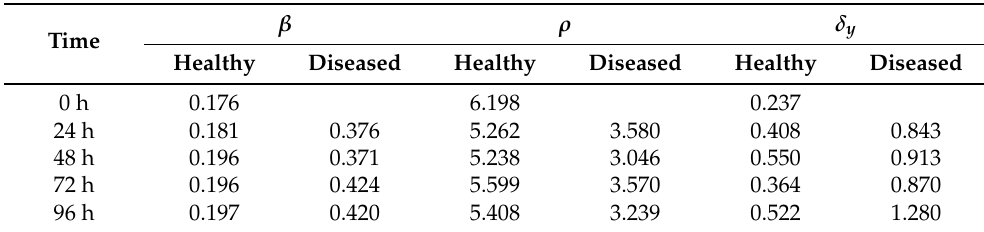
Table 5. The values of β , ρ and δ y associated with the fluorescence data on Healthy and Diseased plants of the fungal pathogen data set. 0 h, ..., 96 h are the five times of the acquisition of chlorophyll fluorescence